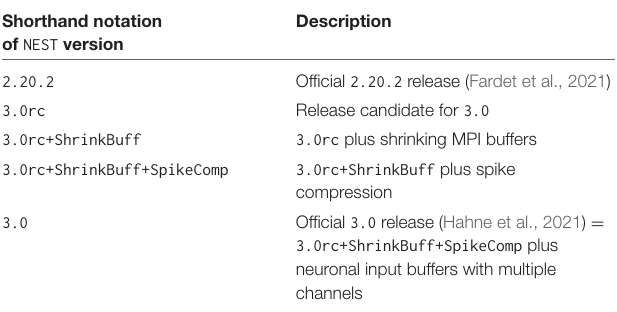
TABLE 1 | Shorthand notation and description of NEST versions used in this work. Shorthand notation of NEST